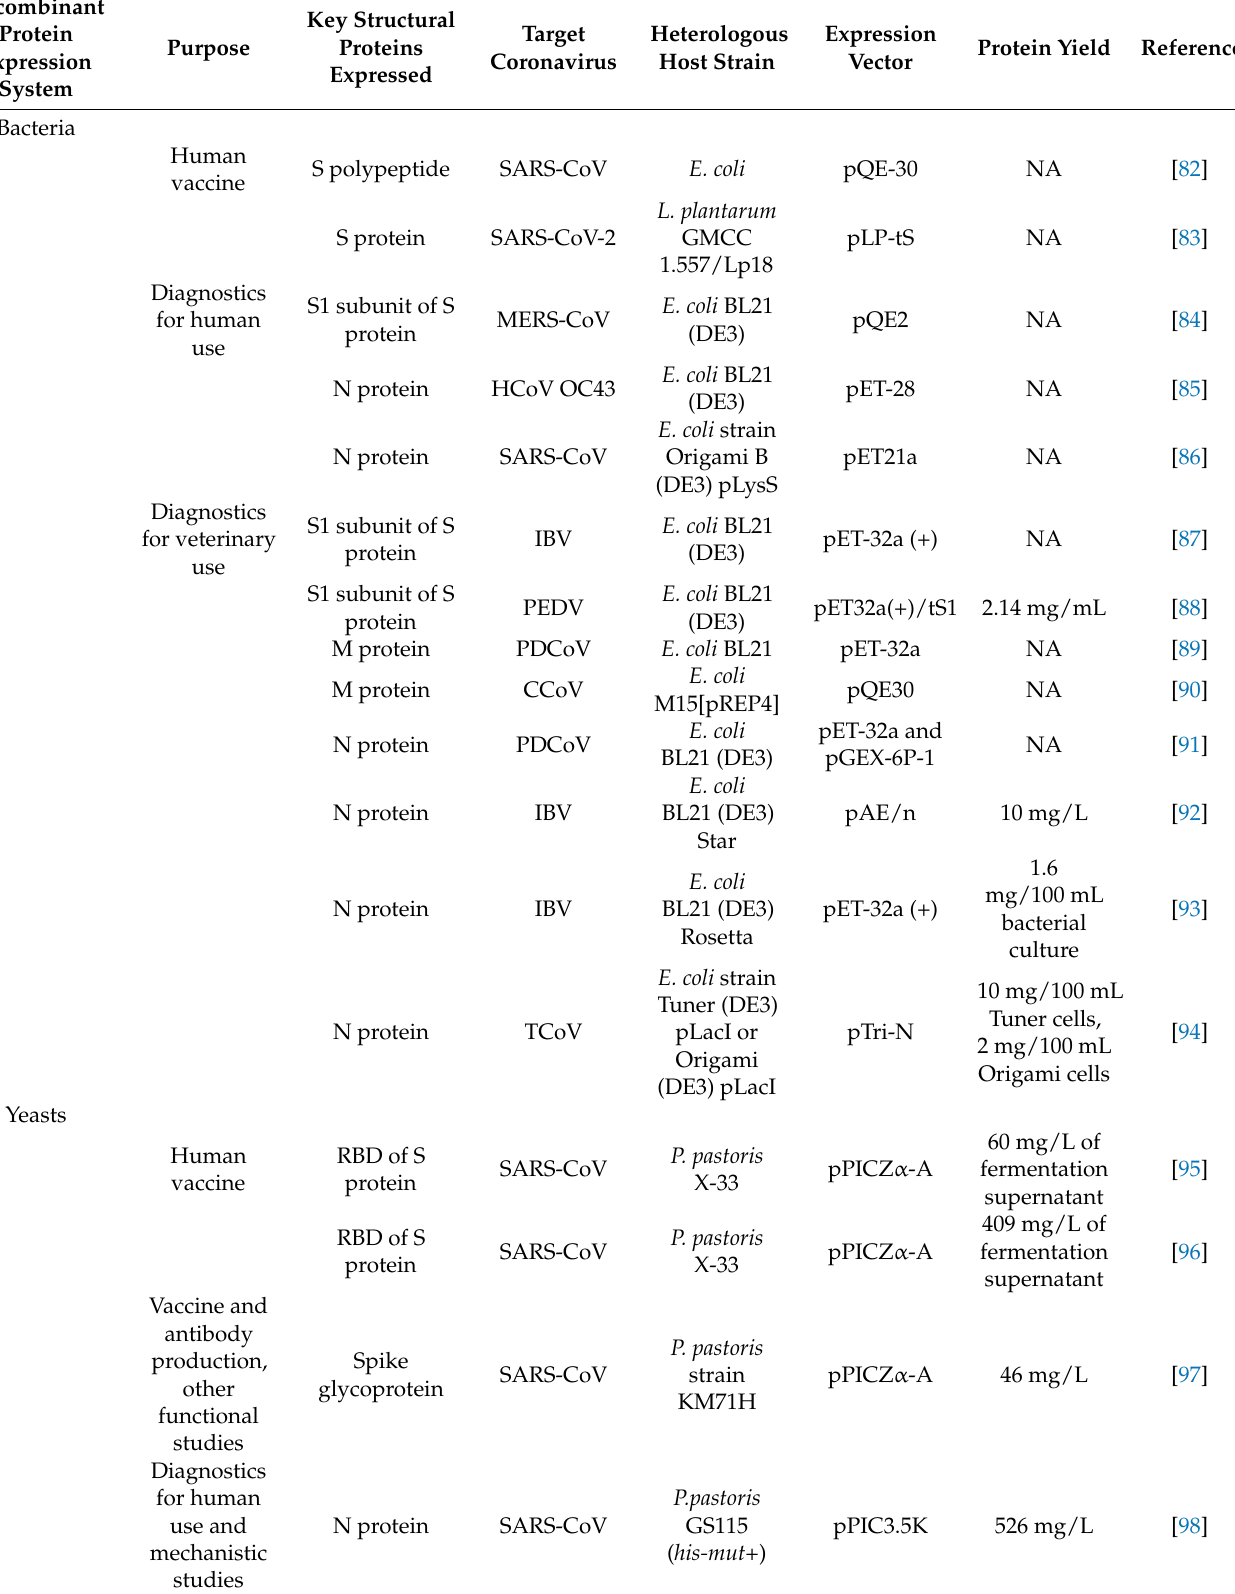
Table 2. Recombinant protein expression system and its various applications on different